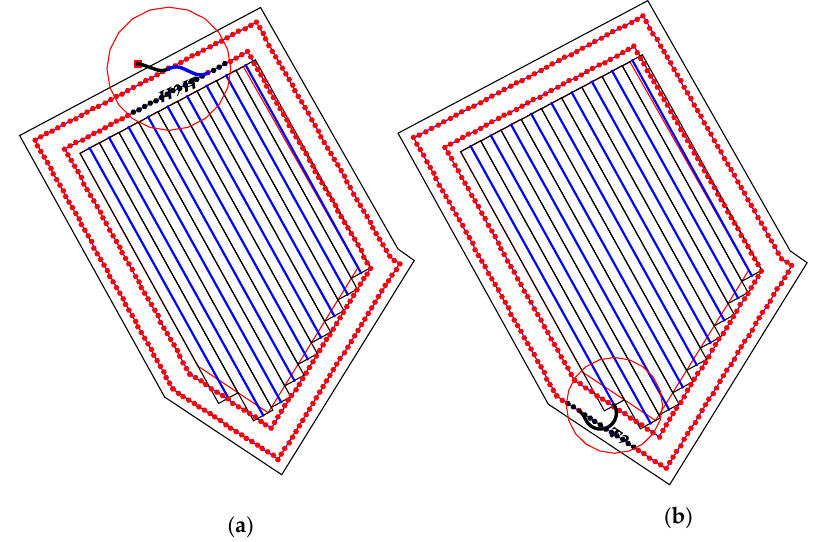
Figure 5. ( a ) The H2H connector (blue path), ( b ) the T2H connector (black path).